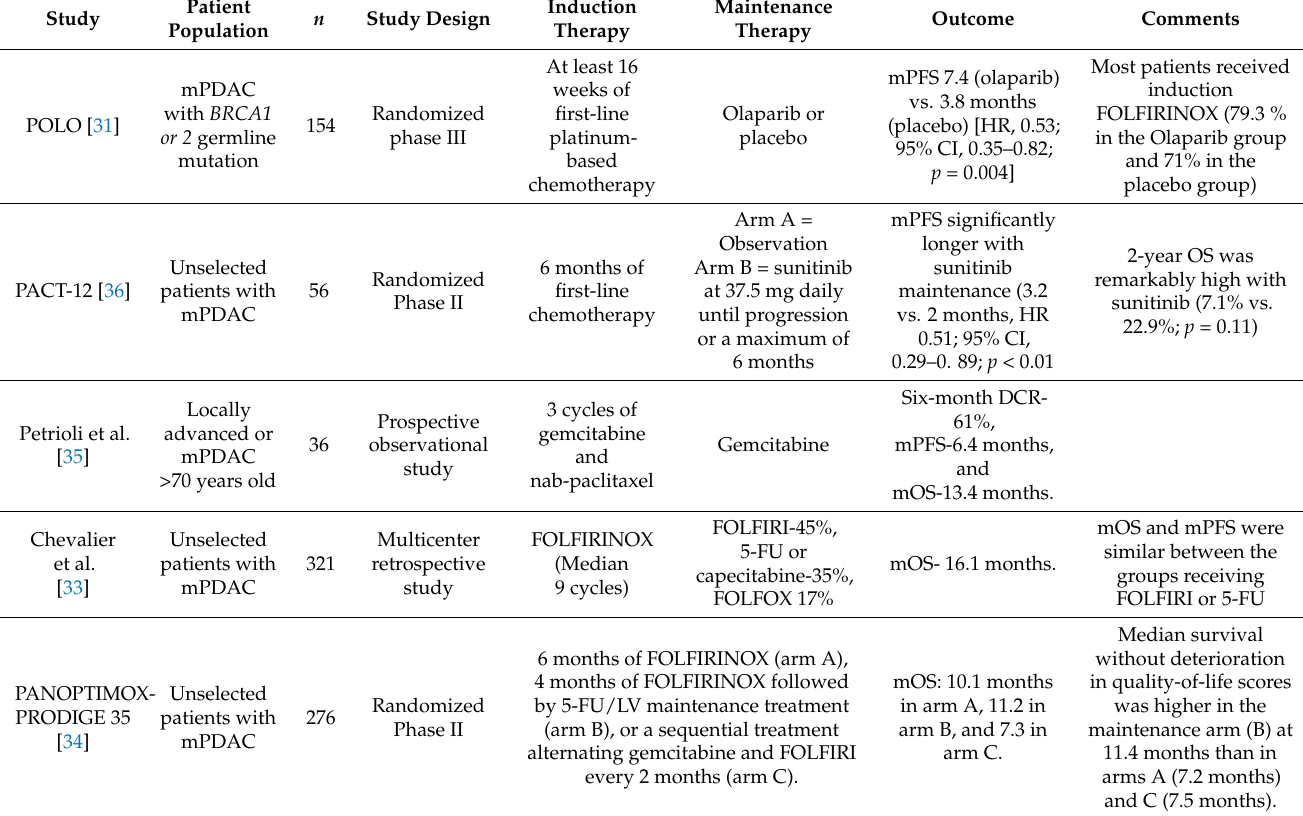
Table 2. Published studies with maintenance treatment regimens in metastatic pancreatic ductal ade-